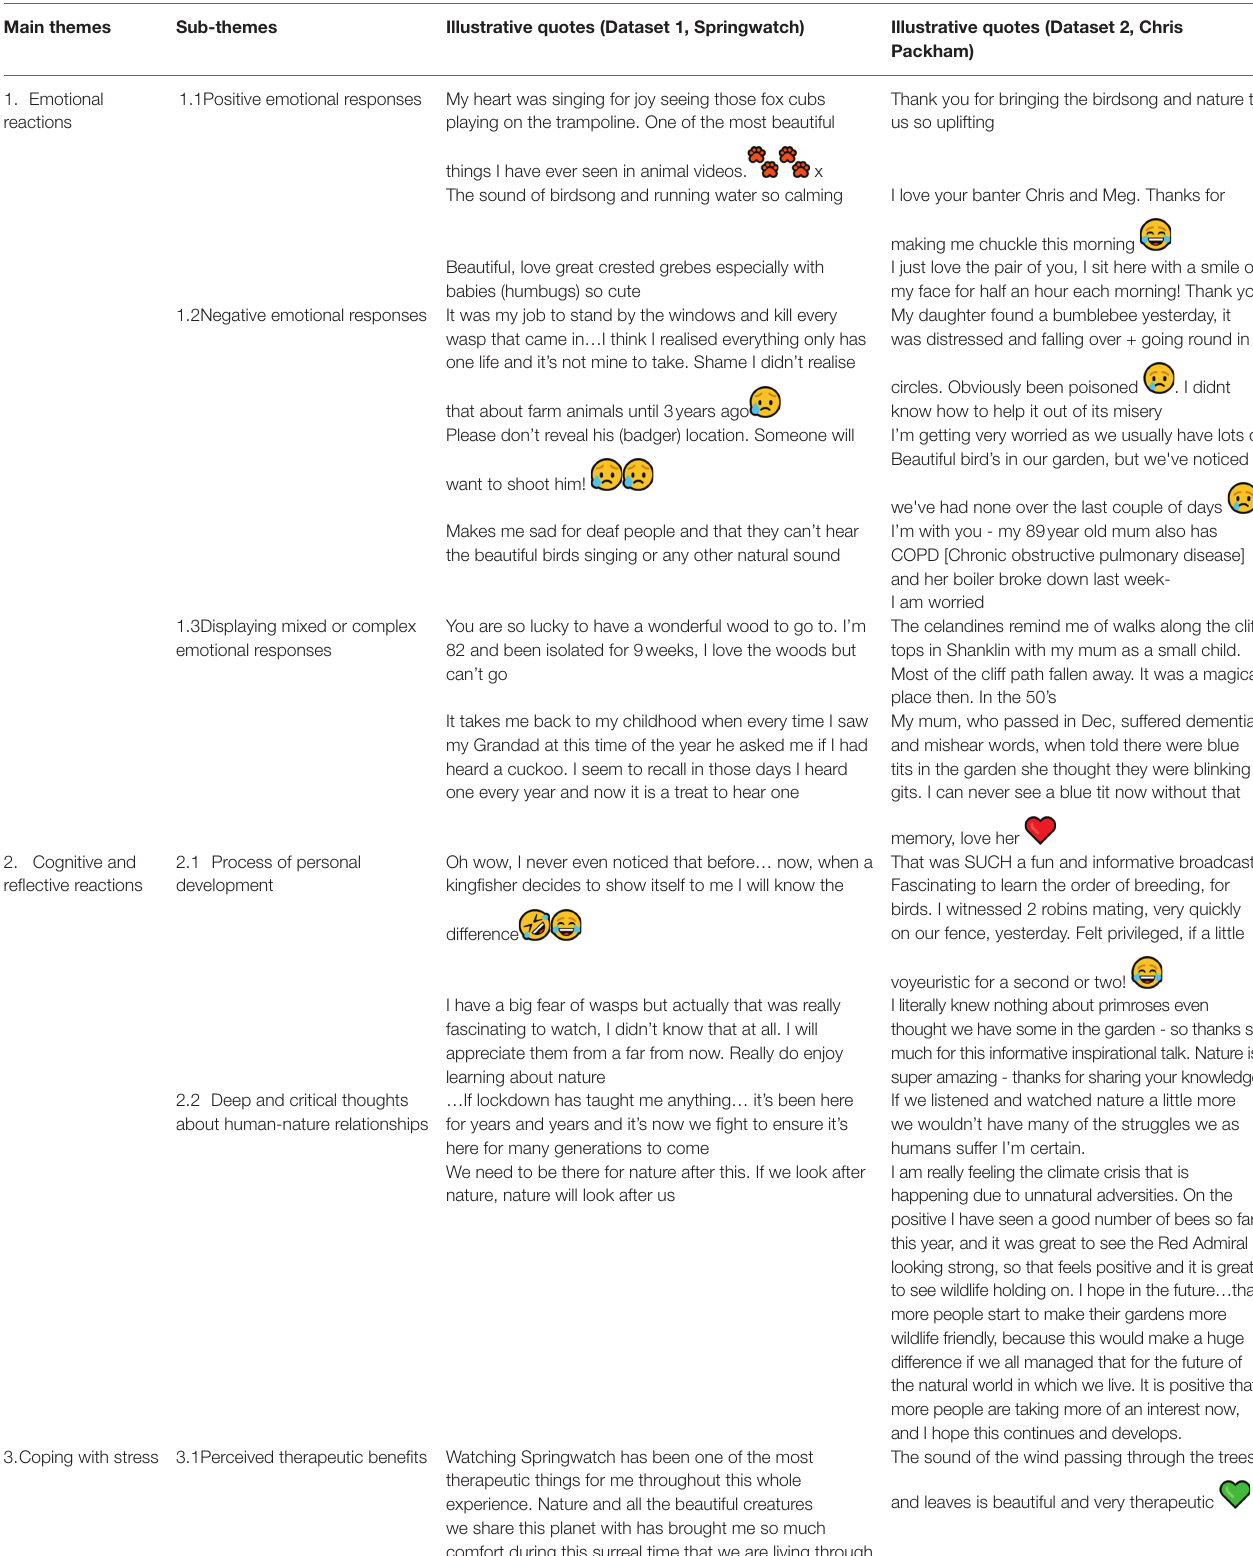
TABLE 2 | Main themes and sub-themes with supportive example